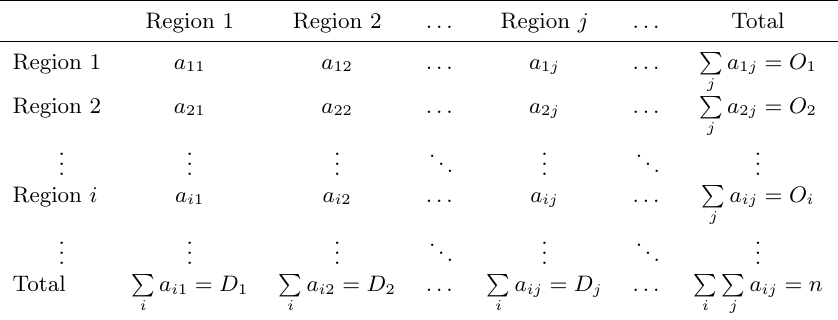
Table 1: Journey-to-work interaction